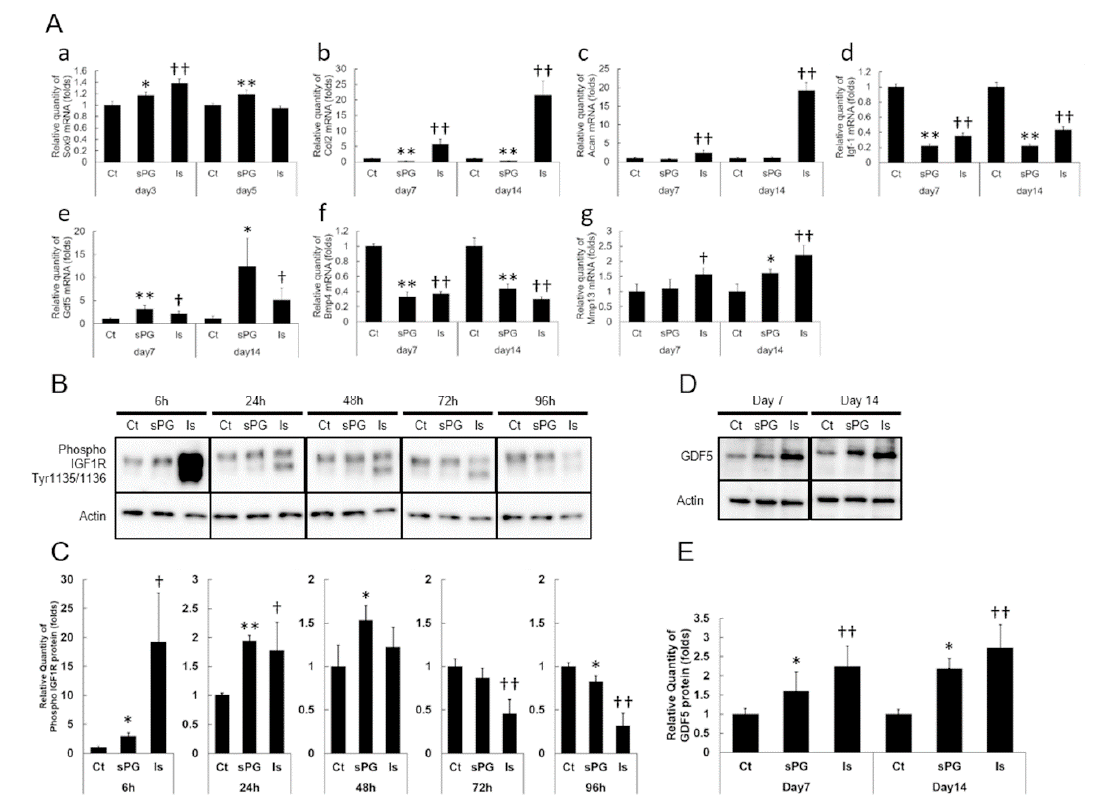
Figure 5. Effects of sPG on chondrogenic differentiation factors in ATDC5 cells. ( A ) Real-time quantitative polymerase chain reaction (PCR) analysis of mRNA expression on chondrogenic differentiation factors Sox9 , Col2a1 , Acan , Igf-1 , Gdf5 , Bmp4 and Mmp13 . Untreated cells (Ct) or cells treated with sPG (50 μ g/mL) or insulin (Is) (10 μ g/mL) were cultured under DME/F12 medium containing 5% FBS at 37 °C in a humidified atmosphere of 5% CO 2 in air for 3–14 days from post-confluence. Relative expression levels of Sox9 ( a ), Col2a1 ( b ), Acan ( c ), Igf-1 ( d ), Gdf5 ( e ), Bmp4 ( f ) and Mmp13 ( g ) in ATDC5 treated without or with sPG or insulin was normalized to an endogenous control, RPS18 . Significant difference of sPG on day 3 or 7 and day 5 or 14 show * p < 0.05; ** p < 0.01 compared to 0 μ g/mL as control, Student ′ s t-test. Significant differences of Insulin on day 3 or 7 and day 5 or 14 show † p < 0.05; †† p < 0.01 compared to 0 μ g/mL as control, Student ′ s t-test. ( B ) Immunoblotting analysis on phosphorylation of IGF-1R in chondrogenic differentiation. ATDC5 cells were treated without (Ct) or with sPG (50 μ g/mL) or insulin (Is) (10 μ g/mL) under DME/F12 medium containing 5% FBS for 6, 24, 48, 72 and 96 h and harvested. Phosphorylation of IGF-1R was analyzed by immunoblotting with phospho-IGF-1R antibody. ( C ) Densitometric analysis of phosph-IGF-1R bands. The obtained bands were densitometrically analyzed by Image J and normalized relative to β - actin, as shown in the graph. Significant differences of sPG show * p < 0.05; ** p < 0.01 compared to 0 μ g/mL as control and insulin show † p < 0.05; †† p < 0.01, Student ′ s t-test. ( D ) Immunoblotting analysis on GDF5 protein in chondrogenic differentiation. ATDC5 cells were treated without (Ct) or with sPG (50 μ g/mL) or insulin (Is) (10 μ g/mL) under DME/F12 medium containing 5% FBS for 7 and 14 days and harvested. GDF5 protein levels were analyzed by immunoblotting with GDF5 antibody. ( E ) Densitometric analysis of GDF5 bands. The obtained bands were densitometrically analyzed by Image J and normalized relative to β -actin, as shown in the graph. Significant differences of sPG on